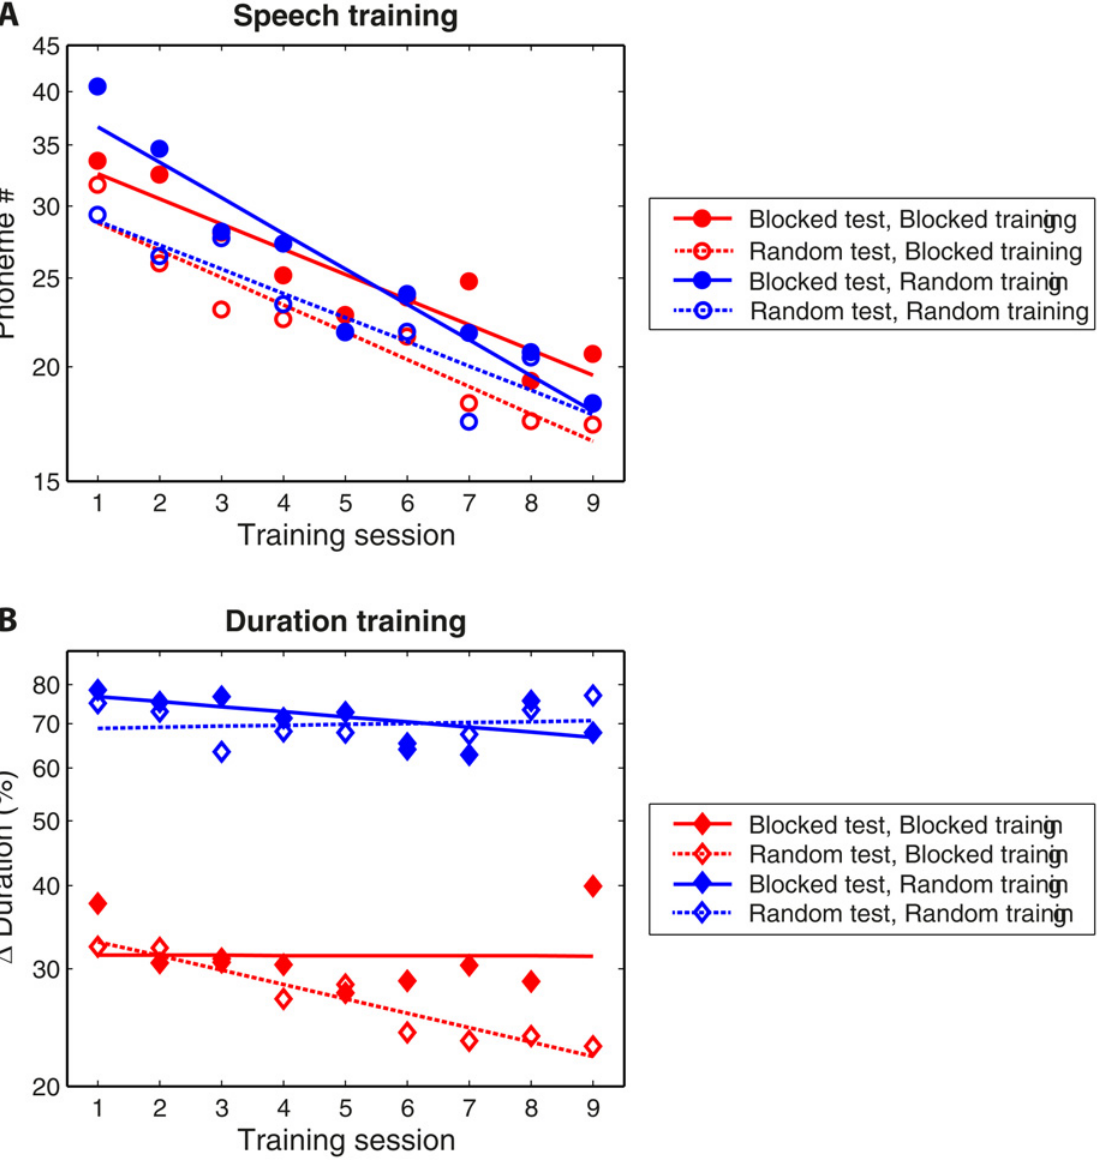
Fig 3. Group mean learning curves for all training regimens. Group mean learning curves for the groups trained on Blocked (red) and Random (blue) Speech (A) and Duration (B) . Dotted and full lines are the regression lines fitted to the mean thresholds averaged across stimuli and participants for each training session, in the groups tested on the random and blocked mode, respectively. Error bars are not shown because they overlap substantially.